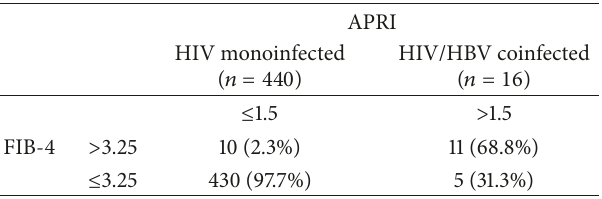
Table 2: APRI and FIB-4 scores results among 456 patients with available results for